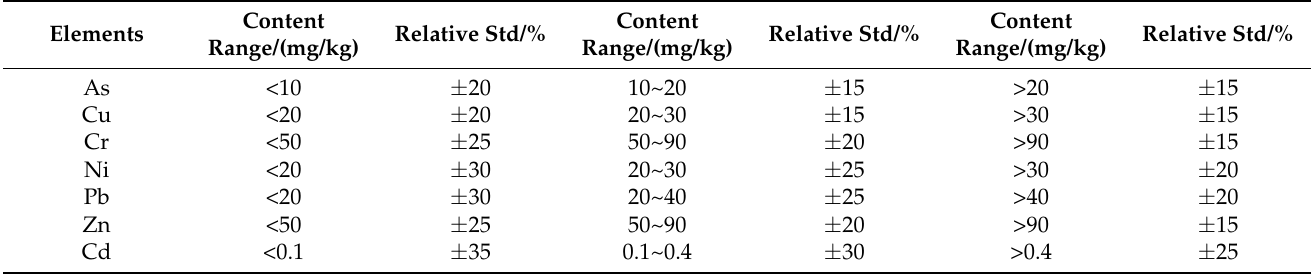
Table A2. Allowable range of precision as defined by the Technical Specification for Soil Environmen- tal Monitoring.